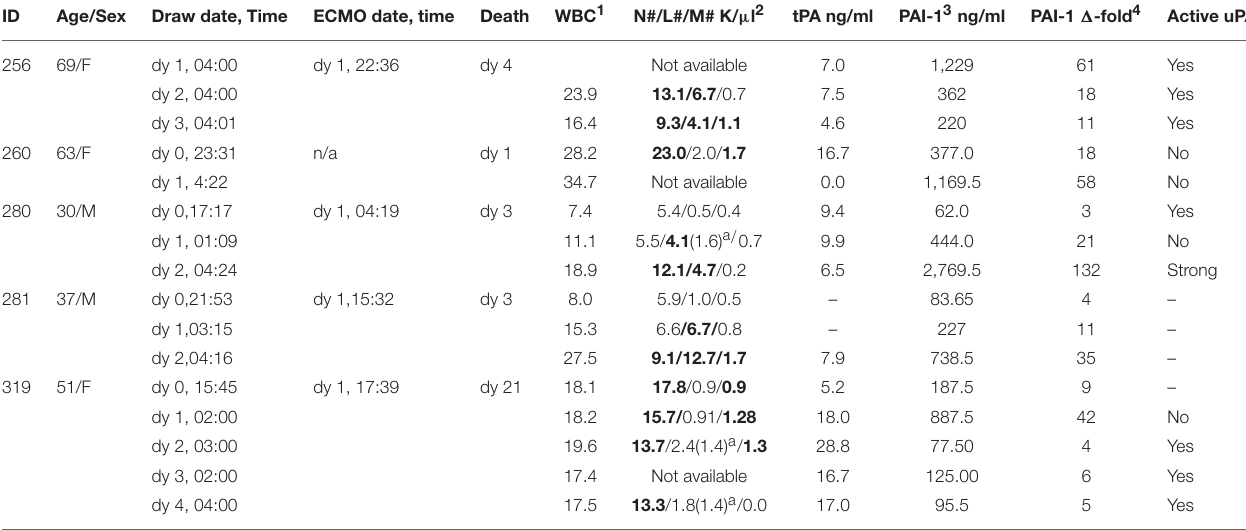
TABLE 1 | Summary of available demographic and PAI-1 expression in class III patients.